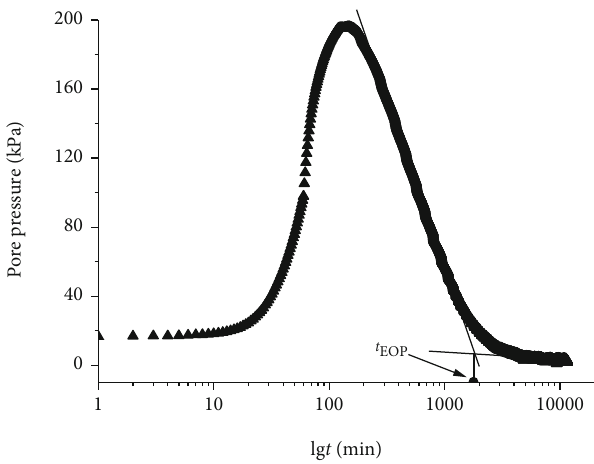
Figure 8: Curve analysis method to determine t